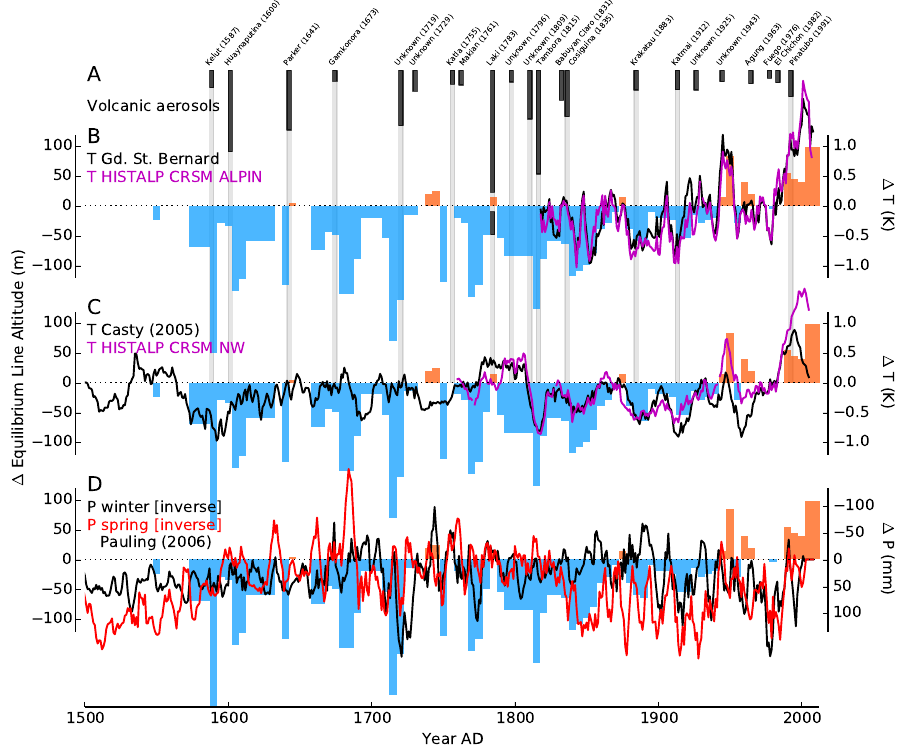
Fig. 2. ELA variation reconstruction leading to best agreement with length change records from seven glaciers (Fig. 1). Modeled ELAs are shown with red and blue colored areas. Instrumental records are shown for comparison in panels (B) and (C) as 5-year running means of summer (JJAS) temperature (data from MeteoSwiss (Begert et al., 2005), Casty et al. (2005) and HISTALP (Auer et al., 2007)). Panel (D) displays winter and spring precipitation as 5-year running means (Pauling et al., 2006). (A) and vertical stripes show timing and magnitude of the Northern Hemisphere stratospheric sulfate loading from explosive volcanism (Gao et al., 2008; Arfeuille et al., 2014).